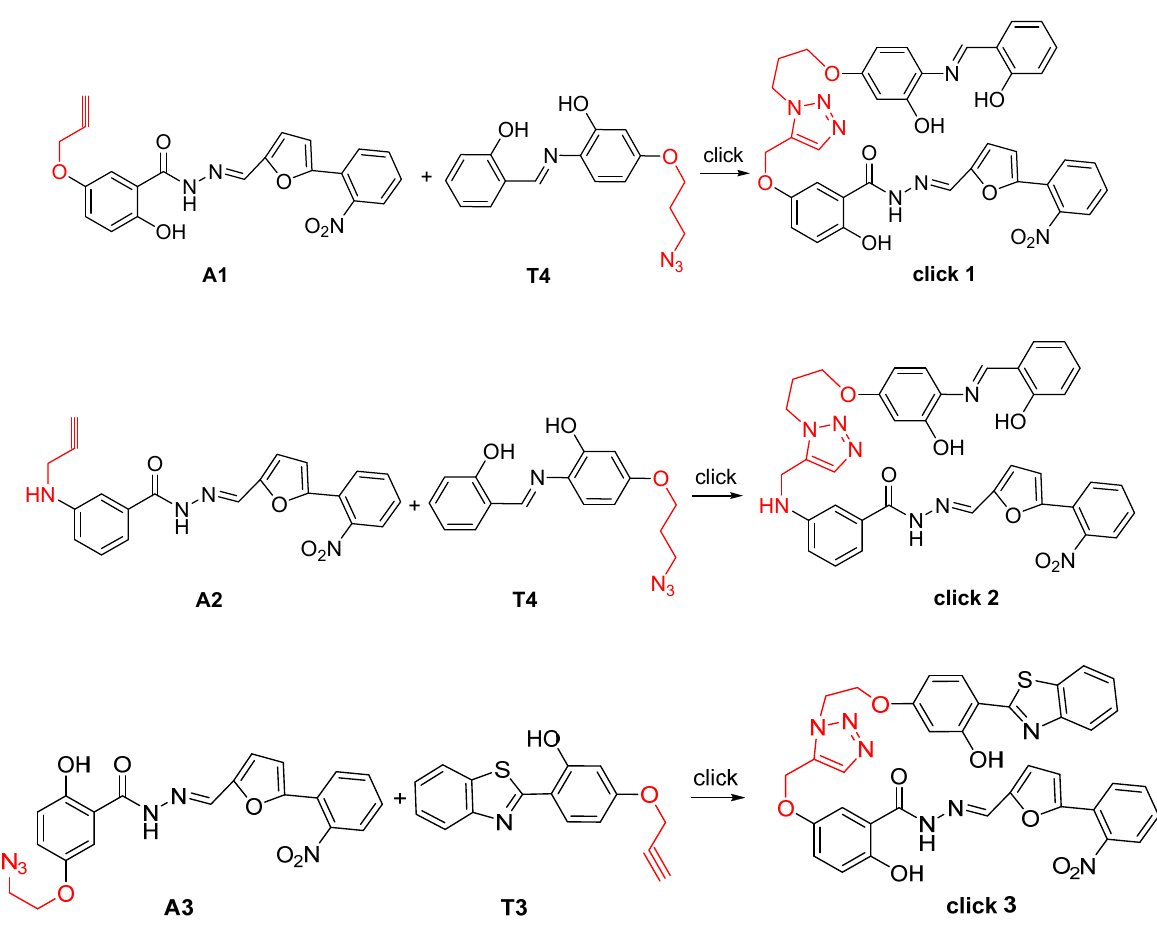
Figure 9. The chemical synthesis routes of the click